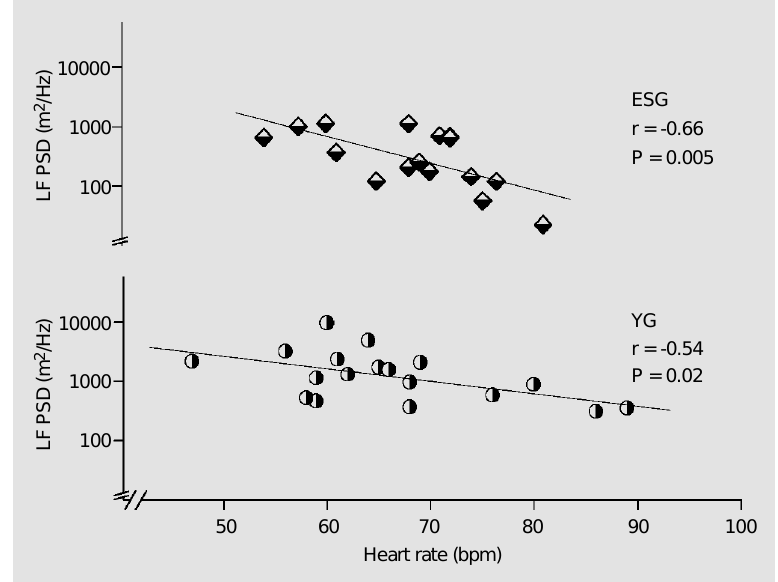
Figure 3 - Fitted regression line of natural log transformation of the power spectrum density (PSD) of the LF band (in ms 2 /Hz) as a function of resting heart rate (bpm) for ESG (N = 16) and YG (N = 18). For abbreviations, see legend to Table